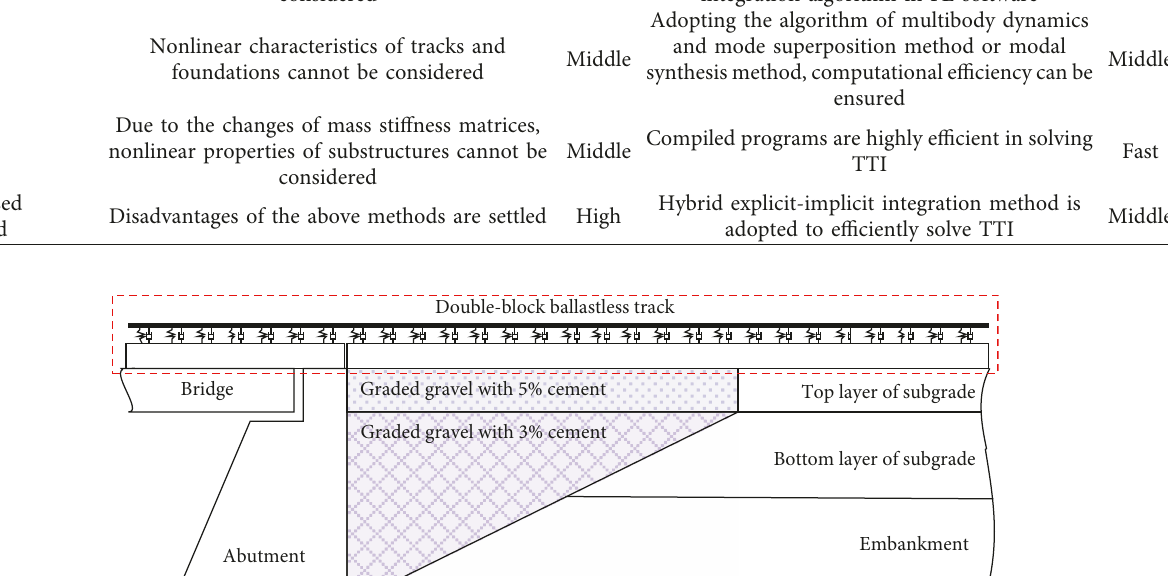
Figure 7: Bridge-subgrade transition section with the double-block ballastless track. Table 5: Key parameters of the bridge-subgrade transition section. Item Value Unit Figure 8: FE model of bridge-subgrade transition section in ANSYS.